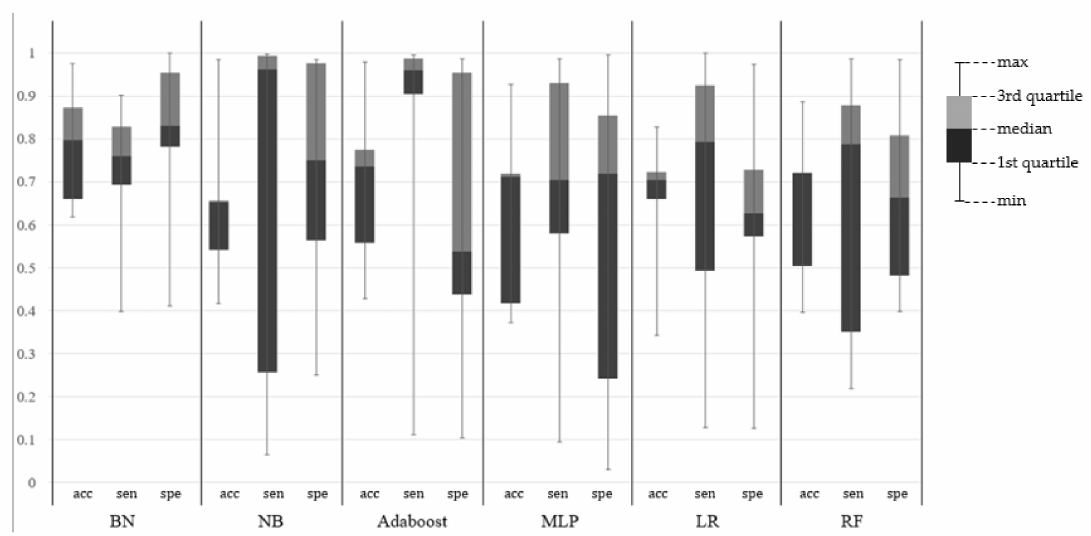
Figure 6. Ten-fold cross-validation for other typical classifiers (accuracy, sensitivity,